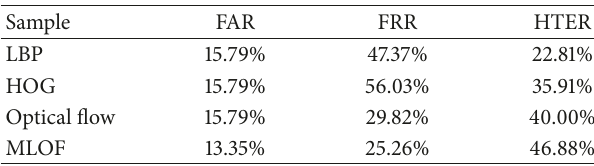
Table 5: Compared the fusion algorithm of this experiment to LBP, HOG, and optical